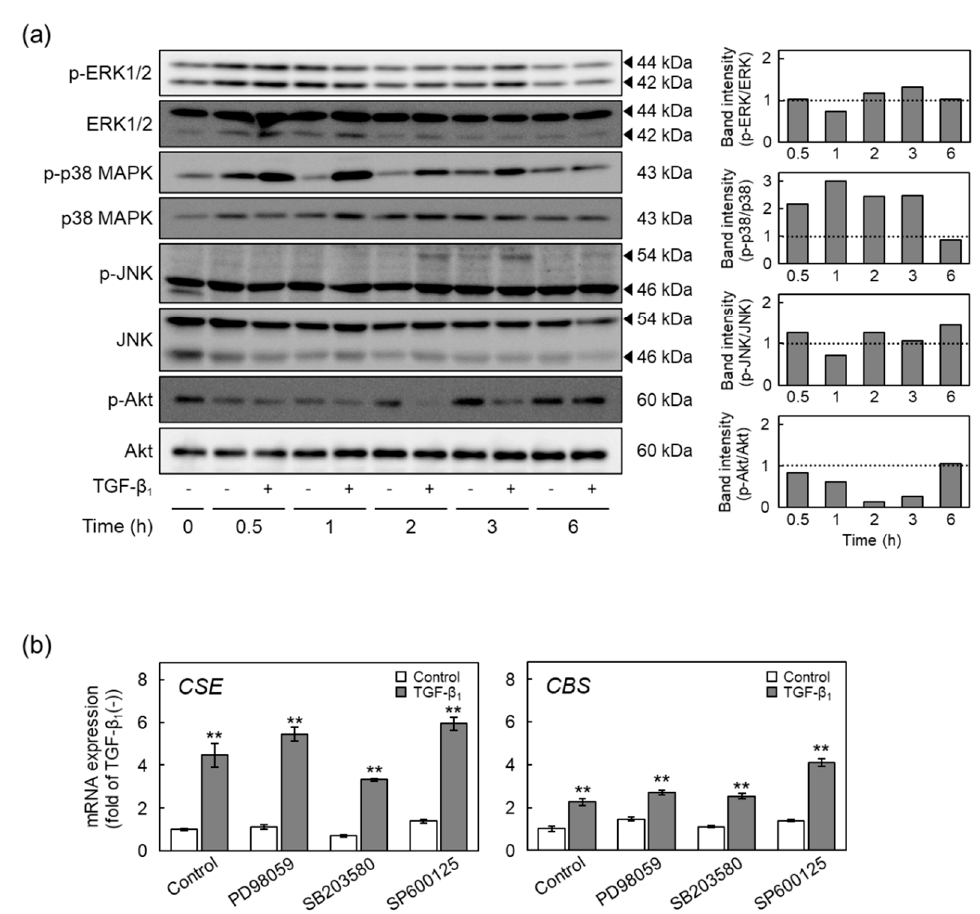
Figure 8. Involvement of the non-Smad pathway in the upregulation of CSE and CBS expression by TGF- β 1 in vascular endothelial cells. ( a ) Phosphorylation of ERK1/2, p38 MAPK, JNK, and Akt in vascular endothelial cells treated with TGF- β 1 . Confluent cultures of vascular endothelial cells were treated with TGF- β 1 (10 ng/mL) for 0.5, 1, 2, 3, or 6 h. The arrowheads indicate the corresponding protein. Quantification of band intensities of phospho-ERK1/2, phospho-p38 MAPK, phospho-JNK, and phospho-Akt (right panels). The data are representative of two independent experiments. ( b ) Expression of CSE and CBS mRNAs in vascular endothelial cells pretreated with either ERK1/2, p38 MAPK, or JNK pathway inhibitor and treated with TGF- β 1 . Confluent cultures of vascular endothelial cells were pretreated with either PD98059 (an ERK1/2 pathway inhibitor), SB203580 (a p38 MAPK pathway inhibitor), or SP600125 (a JNK pathway inhibitor) at 10 µ M for 1 h and then treated with TGF- β 1 (10 ng/mL) for 12 h. Values are means ± S.E. of three independent samples. The data were analyzed using one-way ANOVA, followed by Tukey–Kramer’s test. ** Significantly different from the corresponding control, p <